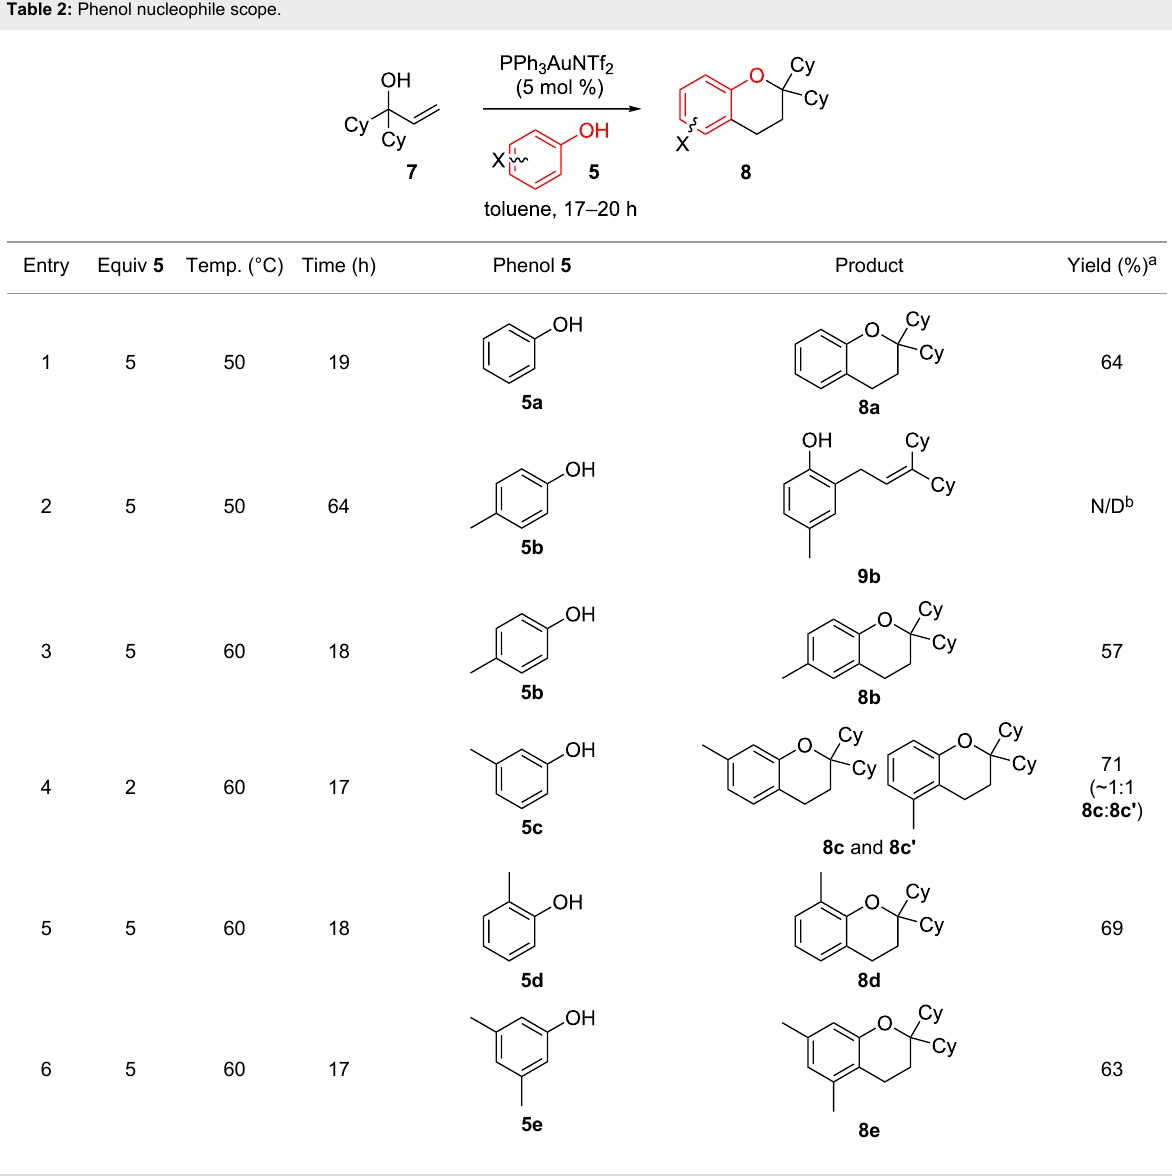
Table 2: Phenol nucleophile scope.